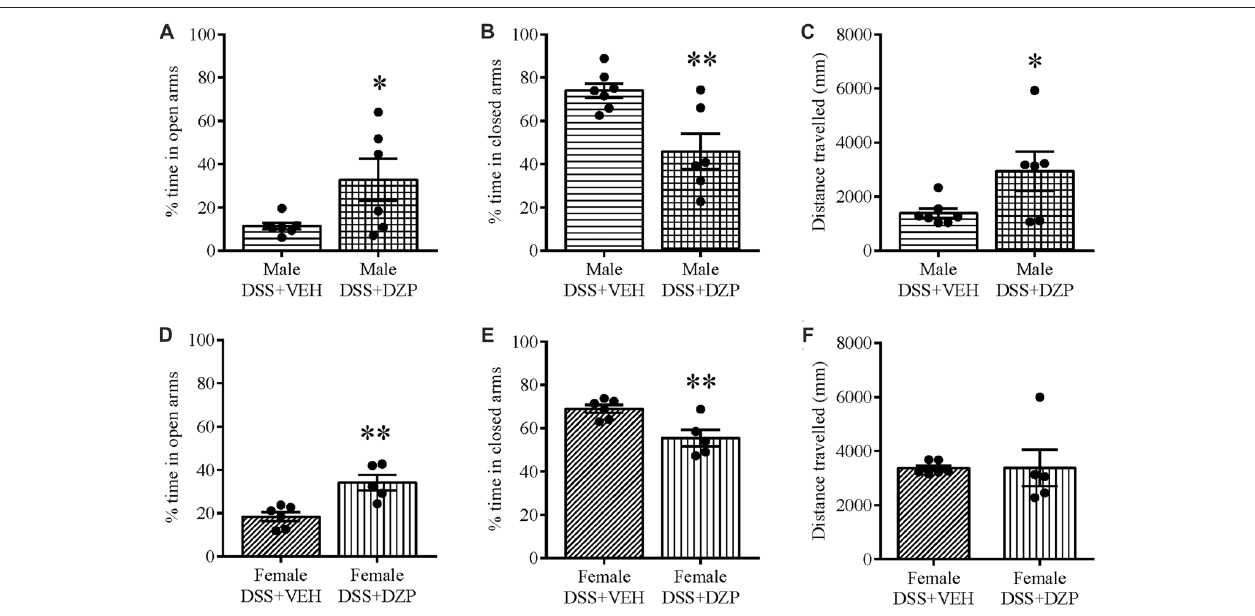
FIGURE 4 | Diazepam (DZP) rescues the anxious phenotype and locomotion in DSS-treated animals. DZP treatment, given 30 min before the EPM test to DSS-treated animals reduced anxiety-related behavior, reflected by the increased percent time spent in the open (A,D) and reduced closed arm percent time (B,E) in both males (A,B ) and females (D,E) . DZP treatment increased locomotor activity in DSS-treated males (C) and rescued (F) the decreased locomotion previously seen in DSS-treated females ( Figures 2F , 3F ). ∗∗ P < 0.01, ∗ P < 0.05 vs. DSS + VEH mice.